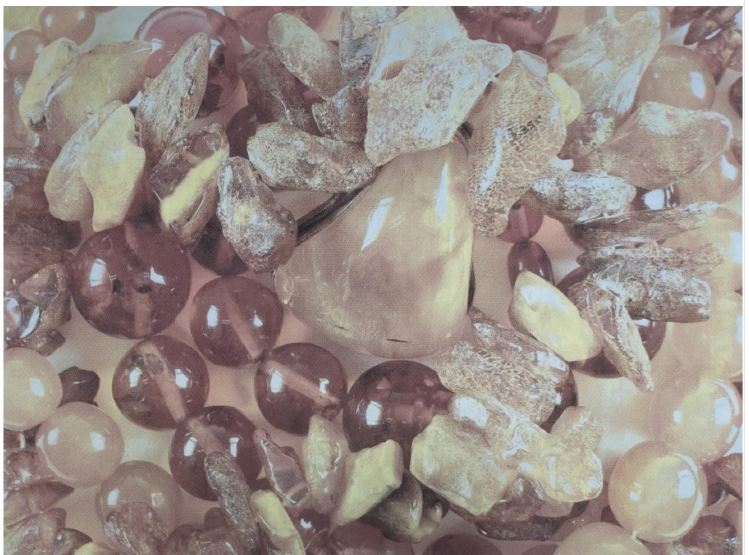
Figure A1. 25LPI, screen-print, 55H mesh, Spectraval™ pigments, RGB, R = 400 g medium, 36 g pigment, G = 400 g medium, 48 g pigment, B = 400 g medium, 40 g pigment, black Plike, film negative, print size 600 mm × 450